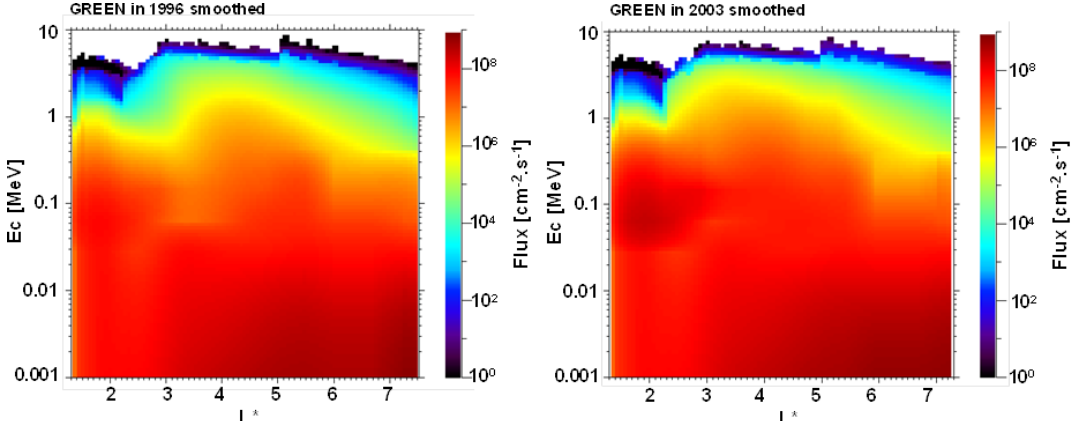
Figure 14. Electron fluxes vs. L ∗ and energy in 1996 and 2003 provided by the GREEN- e model with a simple smooth function.